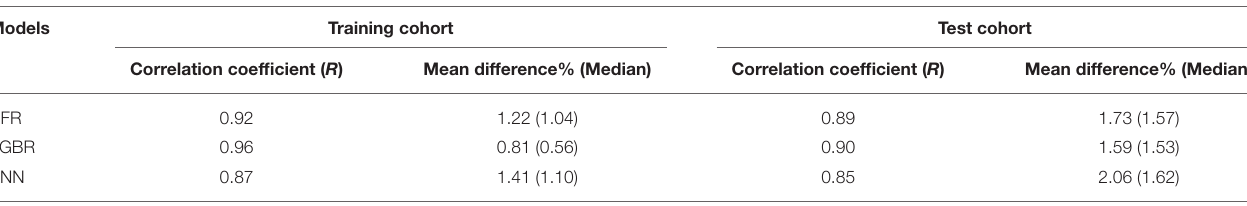
TABLE 2 | Predictive performance of the